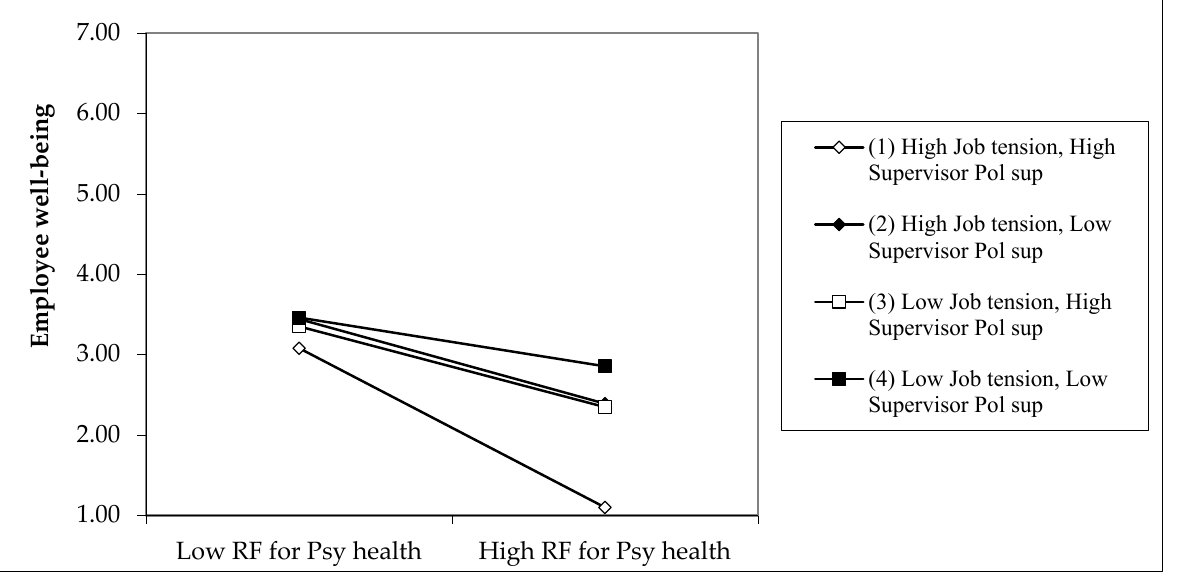
Figure 3. Sample 3: Three-way interaction of risk factors of work on psychological health, job tension, and supervisor political support predicting employee well-being. Note: Calculations are based on coef- ficients from Table 3 . The slope of the relationship between SE and well-being is negative and significant only in the “High job tension—High SPS” condition for Sample 3 (difference of − 0.26). Line (1) in Figure 4 (well-being) for Sample 3 shows a more significant negative relation- ship. The slope difference between “High job tension—High SPS” and “Low job tension— Low SPS” conditions is significant (difference of − 0.17, see Table 7). This result indicates that the interaction effect of SE and well-being is significant in the negative direction of high SPS. The findings demonstrate that the synergistic effects of RFPH and SE and job tension strengthened significantly in a negative direction on well-being when considering high SPS.